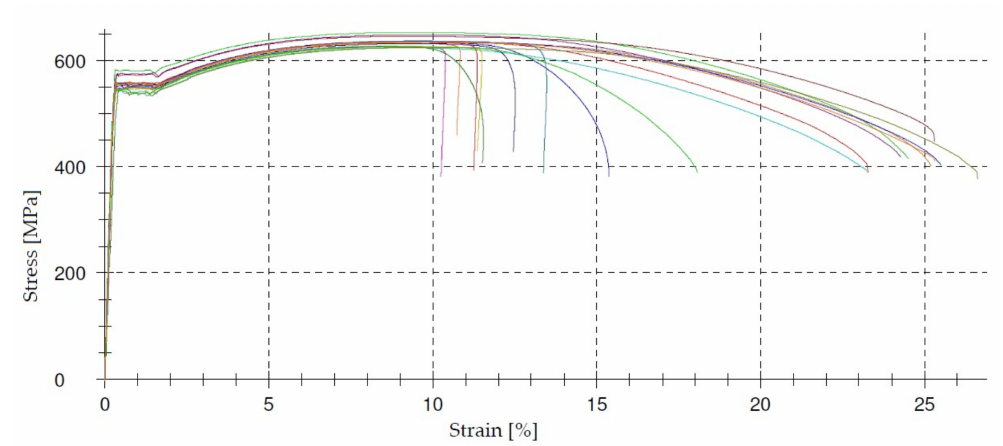
Figure 10. Stress–strain curve for 23 φ 12 bars.